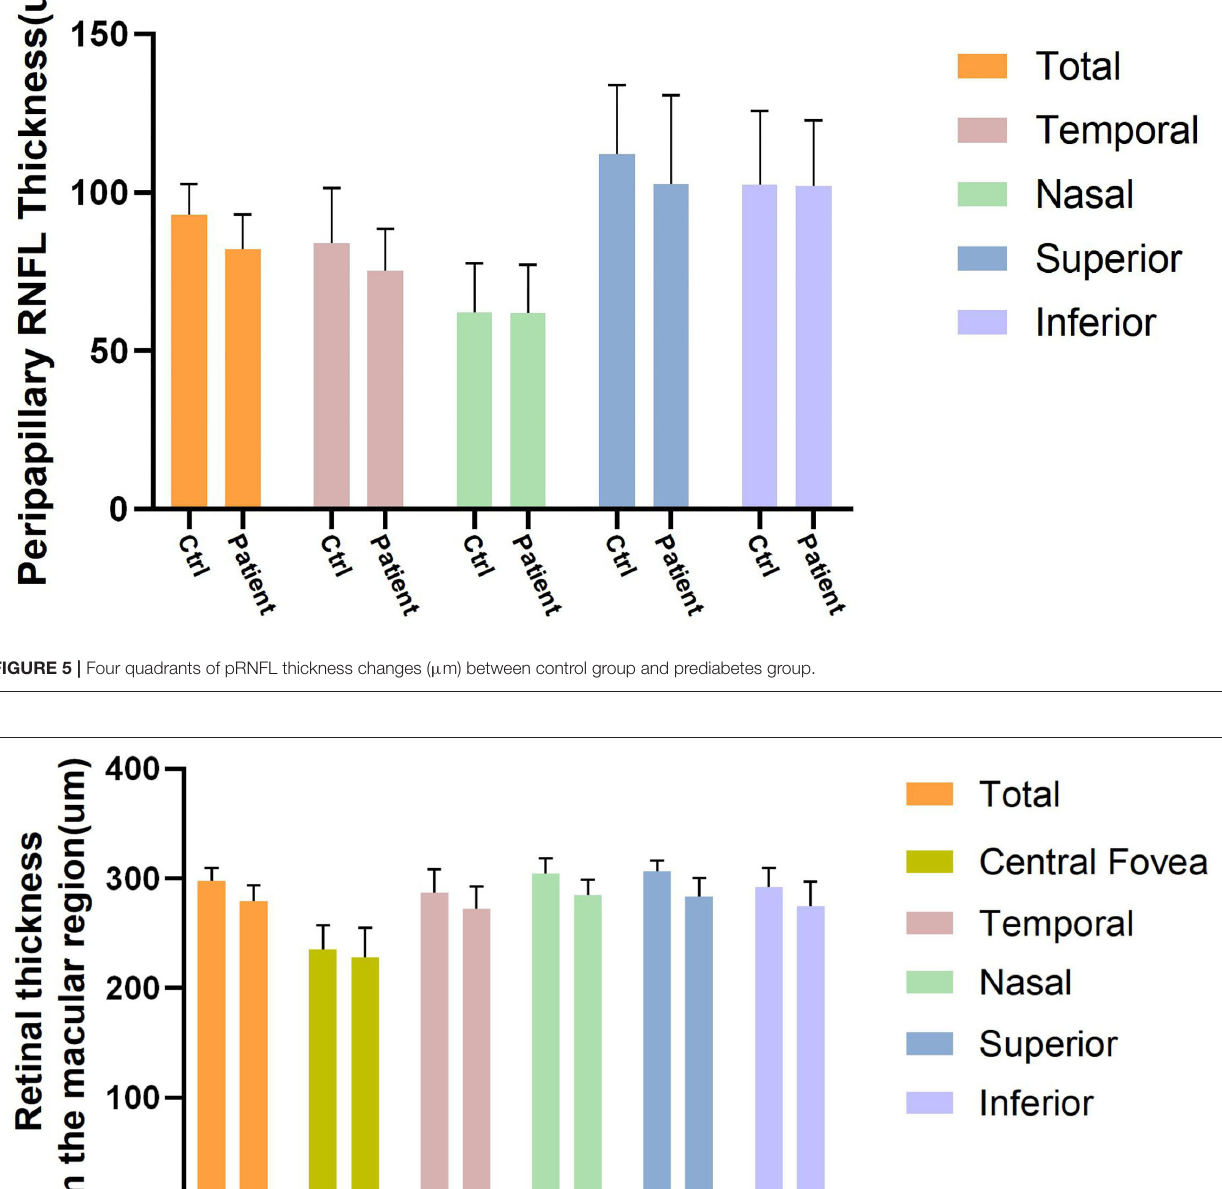
Prediabetes is defined as an abnormal state of glucose homeostasis in which blood glucose levels are higher than normal but not as high as those required for a